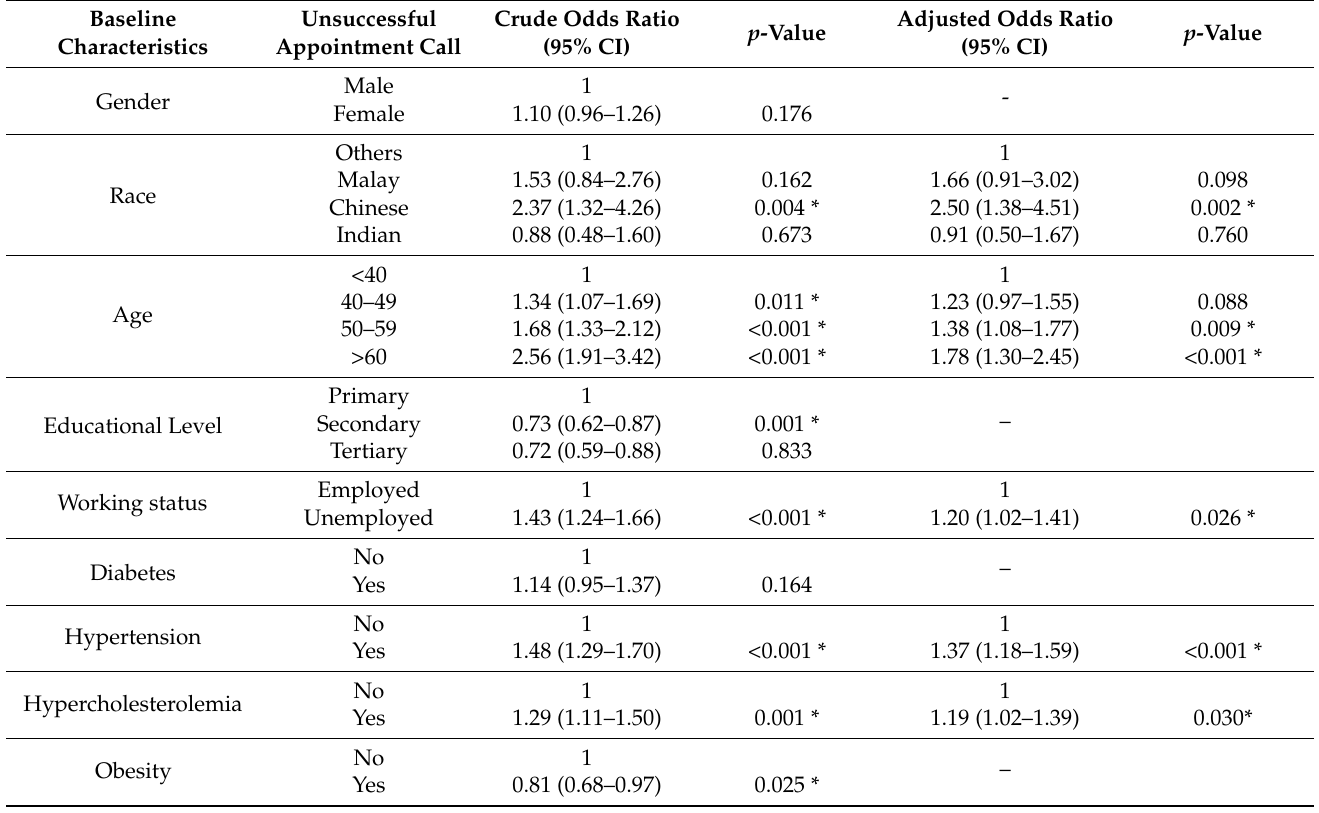
Table 3. Risk factors associated with attrition (unsuccessful) in TMC participants residing in the Kuala Lumpur and Selangor area, Malaysia, March through May